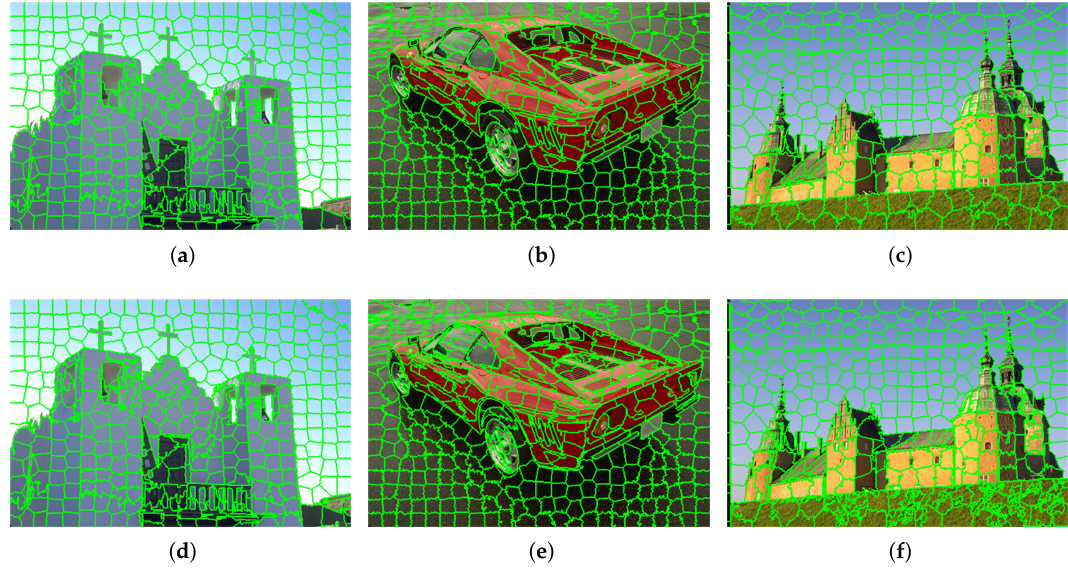
Figure 7. Superpixels generated from SLIC and Purified SLIC with the initial superpixel size 20 × 20: ( a ) SLIC superpixels for Image 24,063; ( b ) SLIC superpixels for Image 29,030; ( c ) SLIC superpixels for Image 201,080; ( d ) Purified SLIC superpixels for Image 24,063; ( e ) Purified SLIC superpixels for Image 29,030; and ( f ) Purified SLIC superpixels for Image